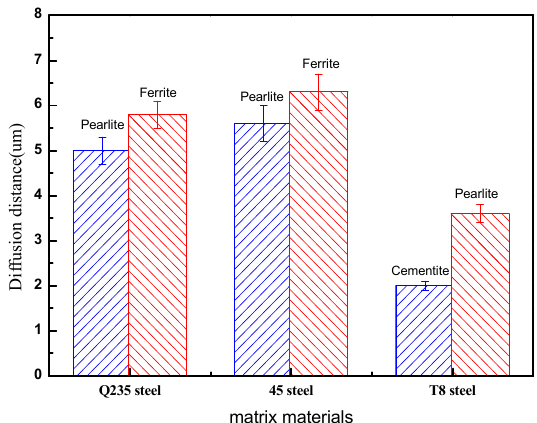
Figure 9. Thicknesses of the diffusion layer of the steel/copper bimetallic castings obtained with different structures of the carbon steel.